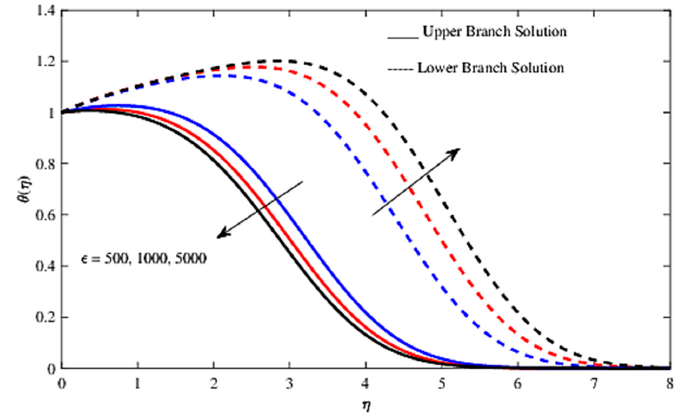
Figure 7. Temperature profiles θ ( η ) for several values of ε when λ = − 1.2, M = 0.5, Q = 0.1 and Pr = 1.0.